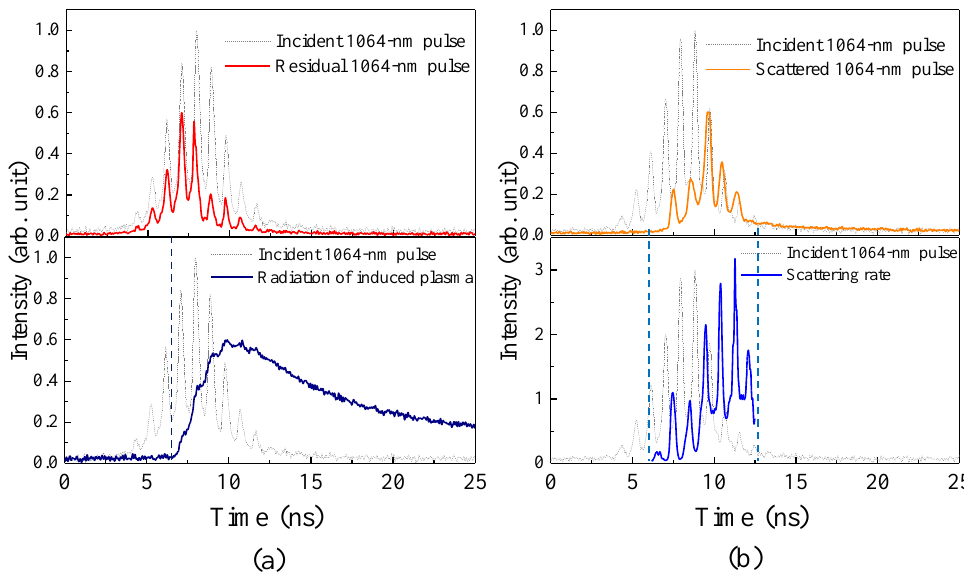
Figure 4. ( a ) Temporal characteristics for the 1064-nm incident pulse, 1064-nm residual pulse, white-light radiation of induced plasma. ( b ) Temporal characteristics for the 1064-nm incident pulse, the 1064-nm scattered pulse and the calculated scattering rate.